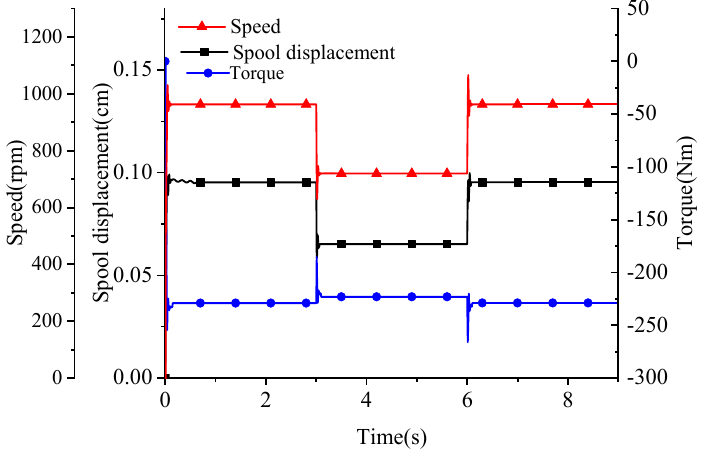
Figure 18. Spool displacement, speed and torque curve under flow variation. Pressure, flow rate and main spool displacement curves of relief valve under tradi- tional working mode and with energy regeneration are given in Figure 19. The outlet pres- sure of the proportional relief valve is 0 MPa from 0–0.5 s, and the relief valve works in the traditional overflow mode. At 0.5 s, the system performs energy recovery, and the outlet pressure of the relief valve is 15 MPa. At this time, the displacement of the main valve core increased immediately, from 0.04 to 0.072 cm; the pressure at the inlet of the overflow valve decreased from 22–21.5 MPa, while the system flow remained unchanged. Compared with the traditional working mode, the flow fluctuation of the system de- creased and became more stable. This shows that the inlet pressure can be reduced and the pressure regulating deviation of the overflow valve can be reduced to a certain extent when the energy recovery unit is added.